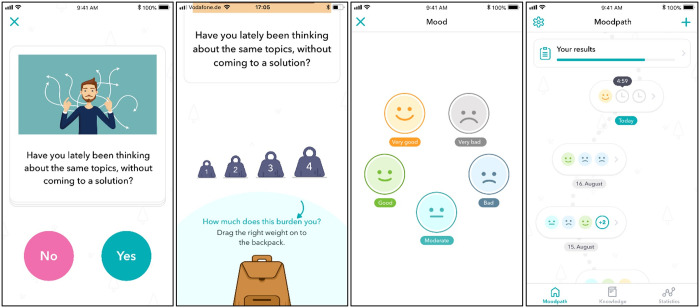
Moodpath screens (images reproduced with permission from Aurora Health GmbH).